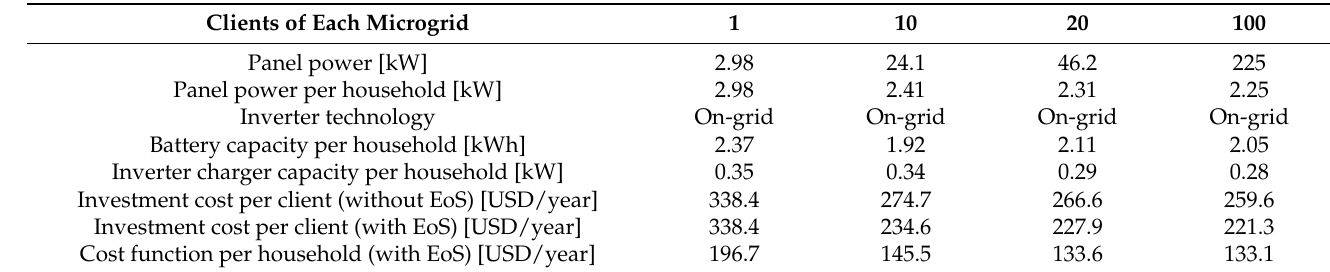
Table 6. Results for an 8 h fault (start time: 906 h, Case 1).